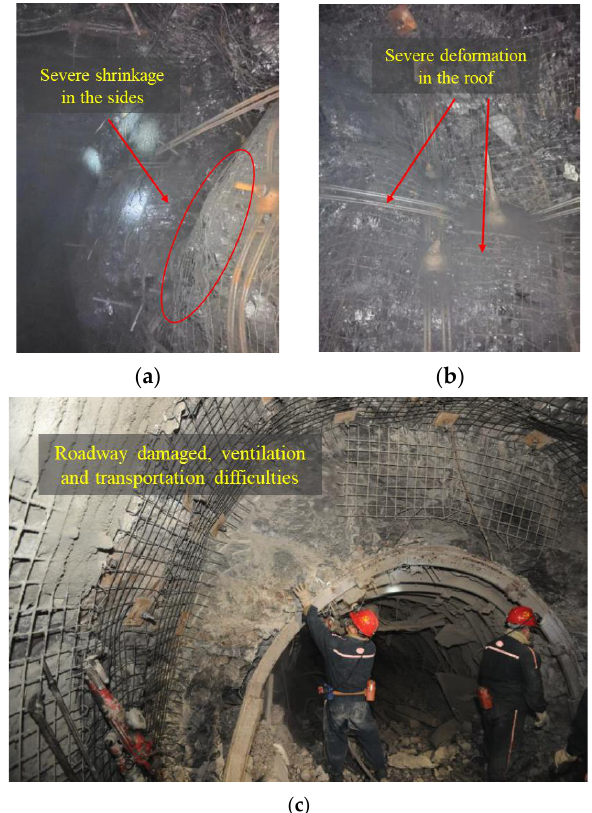
Figure 1. Deformation of soft rock roof [12]. ( a ) Severe shrinkage; ( b ) Severe deformation; ( c ) Roadway damaged.